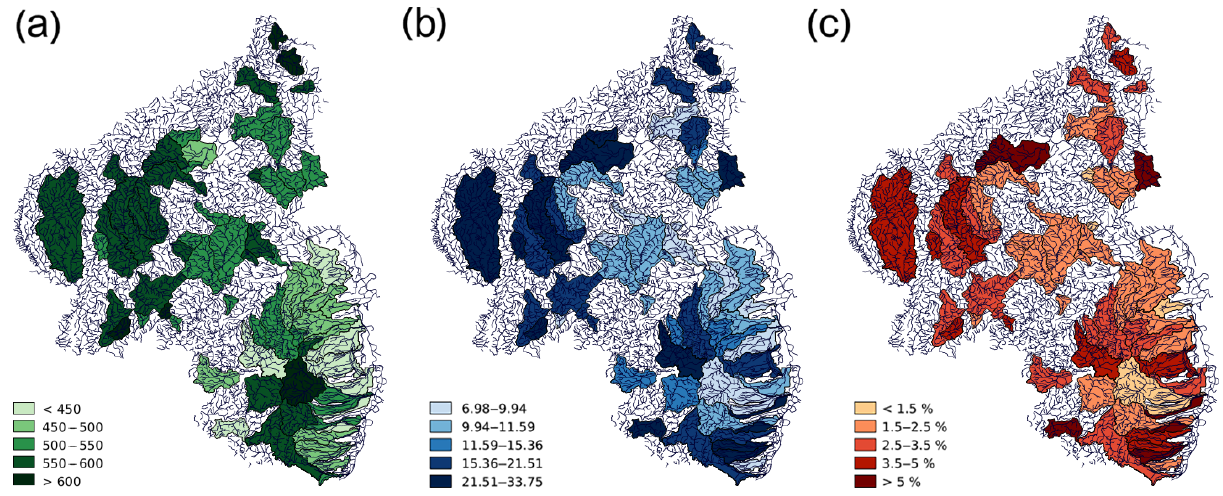
Figure 5. Map of 3rd and 4th order catchments showing (a) mean NPP (gCm − 2 yr − 1 ), (b) aquatic export (gCm − 2 yr − 1 ) and (c) ratio aquatic export/NPP